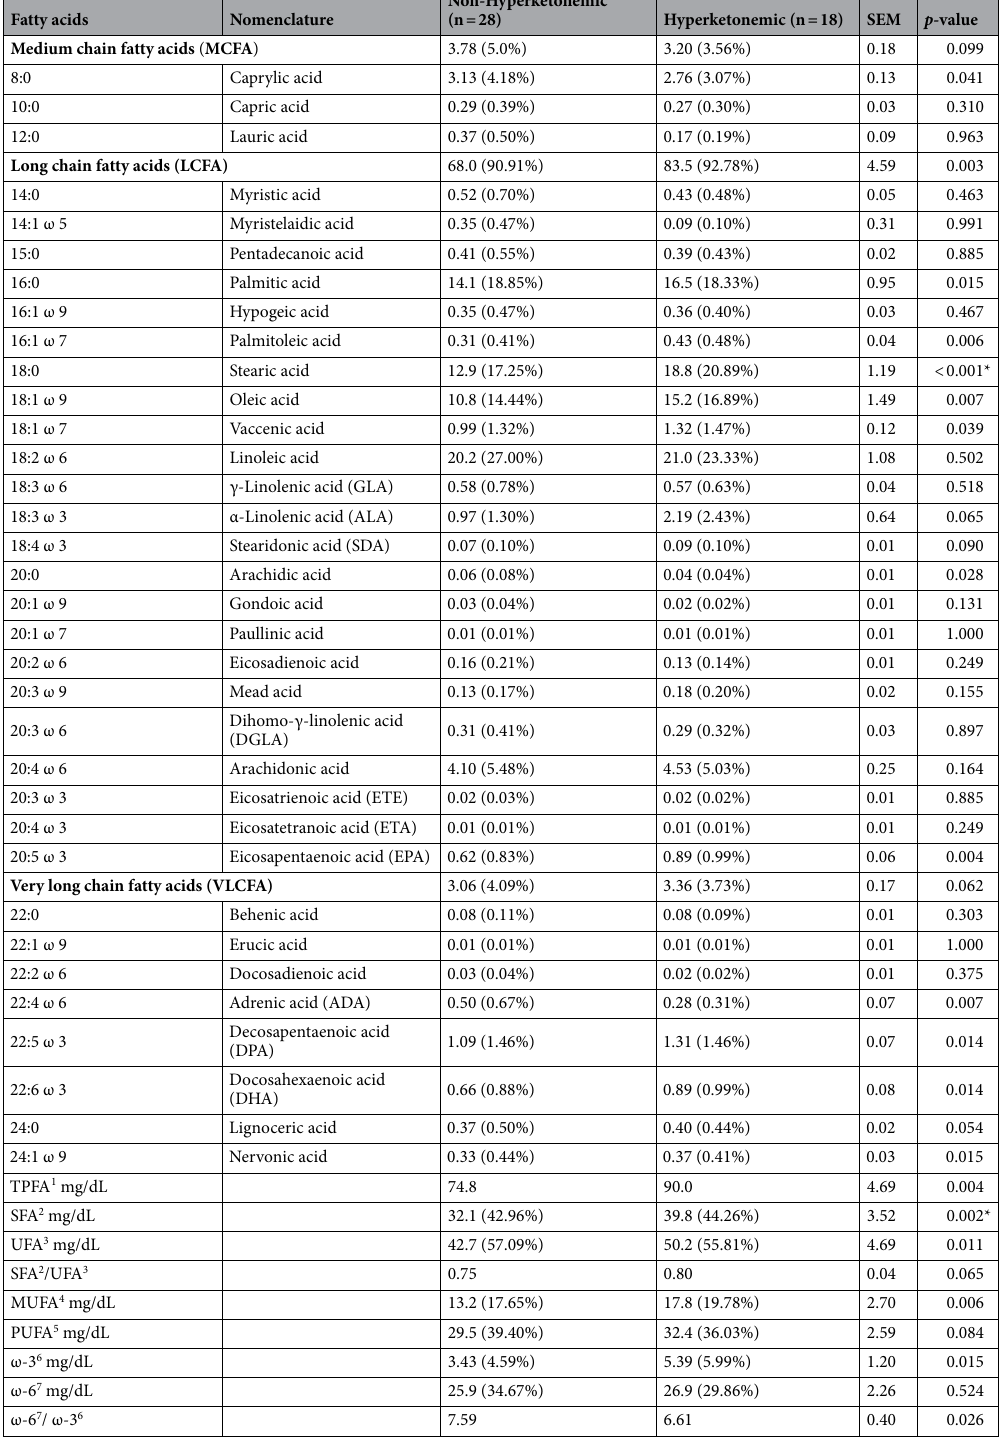
Table 3. Total plasma fatty acid (TPFA) profile expressed as mg/dL of plasma and percent of TPFA of ewes categorized as non-hyperketonemic group with low BHB or hyperketonemic group with high BHB (BHB > 0.86 mmol/L). 1 Total plasma fatty acids. 2 Saturated fatty acids. 3 Unsaturated fatty acids. 4 Mono- unsaturated fatty acids. 5 Polyunsaturated fatty acids. 6 Fatty acids ω-3. 7 Fatty acids ω-6. *Significant interaction of the parity